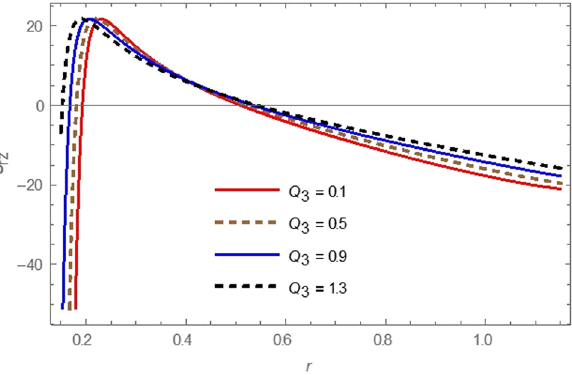
Figure 16: E ff ect of di ff erent values of t on stress with